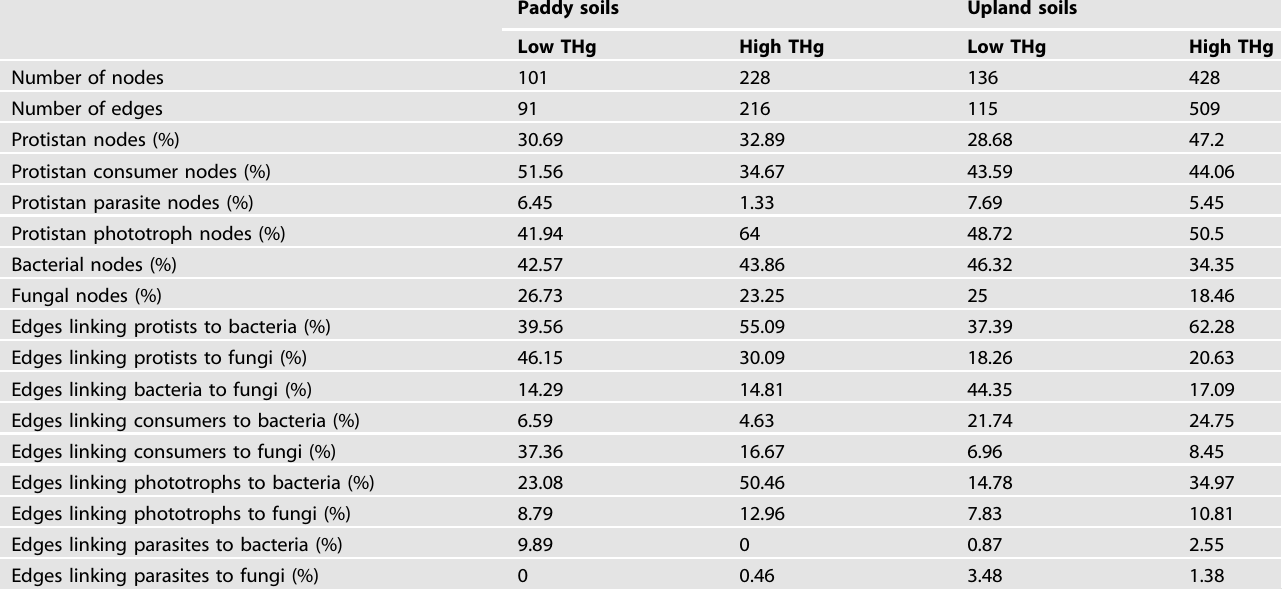
Table 2. Topological indices of networks in Fig.